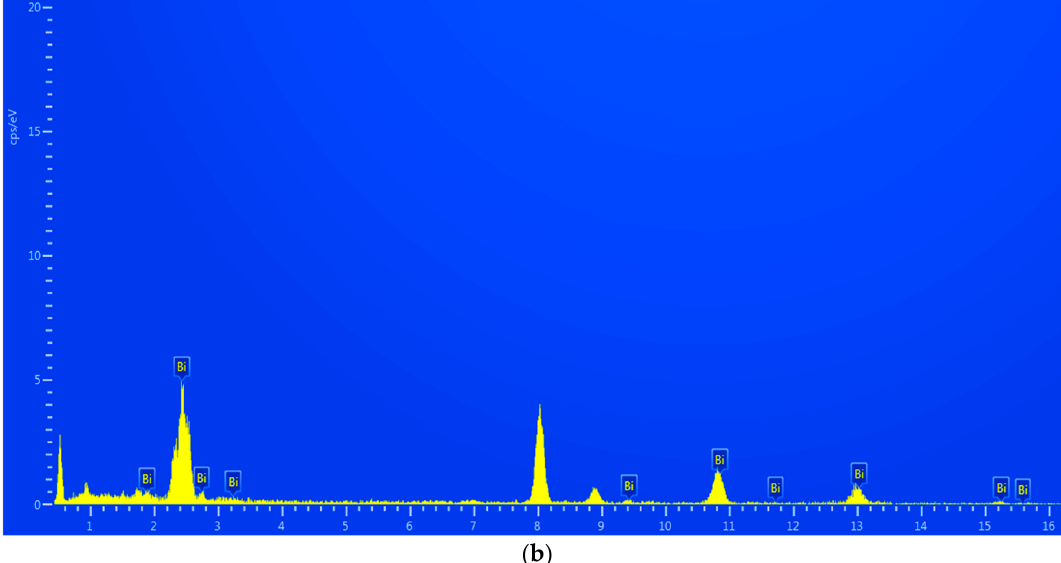
Figure 2. ( a ) Energy dispersive X-ray spectroscopy (EDS) spectrum for the region in Figure 1c , ( b ) EDS spectrum with peaks corresponding to bismuth.